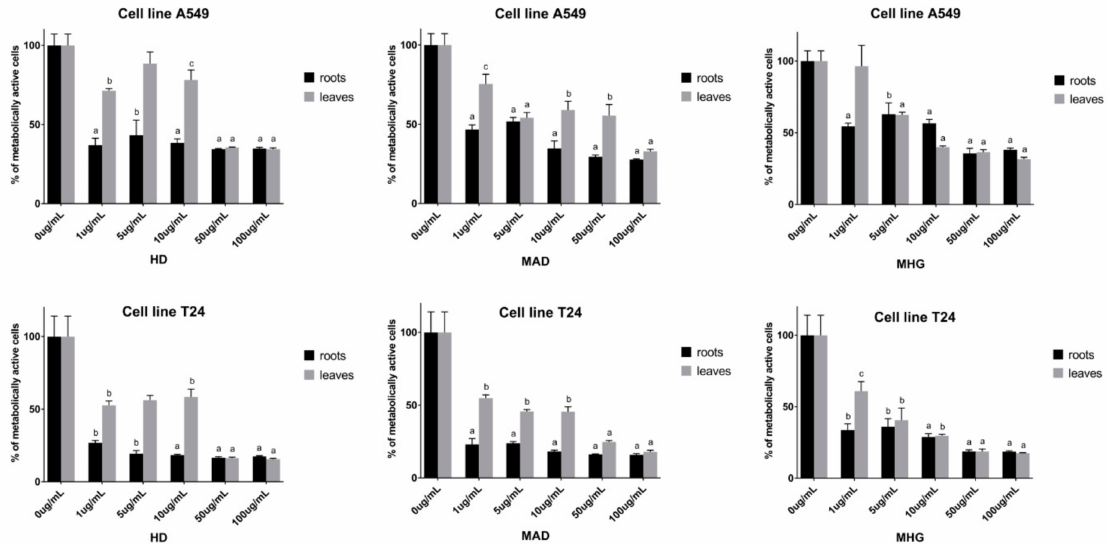
Figure 2. Percentage of metabolically active human lung carcinoma cell A549 and bladder cancer cell T24 lines after 72 h of incubation with di ff erent concentrations of volatiles obtained by HD, MAD, and MHG from the leaves and the roots of horseradish. Calculated IC 50 values ( µ g / mL) are given in Table S1. Each data point is presented as mean ± SD (n = 3). Lower case letters represent significance